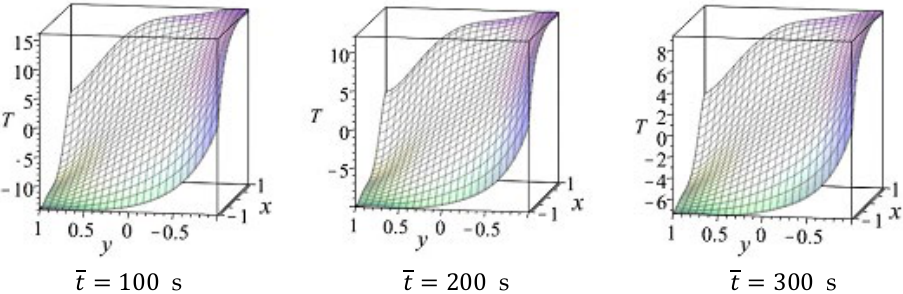
and for 0.5 m/s, °C , 𝑧𝑧 = 0 𝑇𝑇 𝜌𝜌 = − 19 𝑣𝑣 𝑎𝑎 =